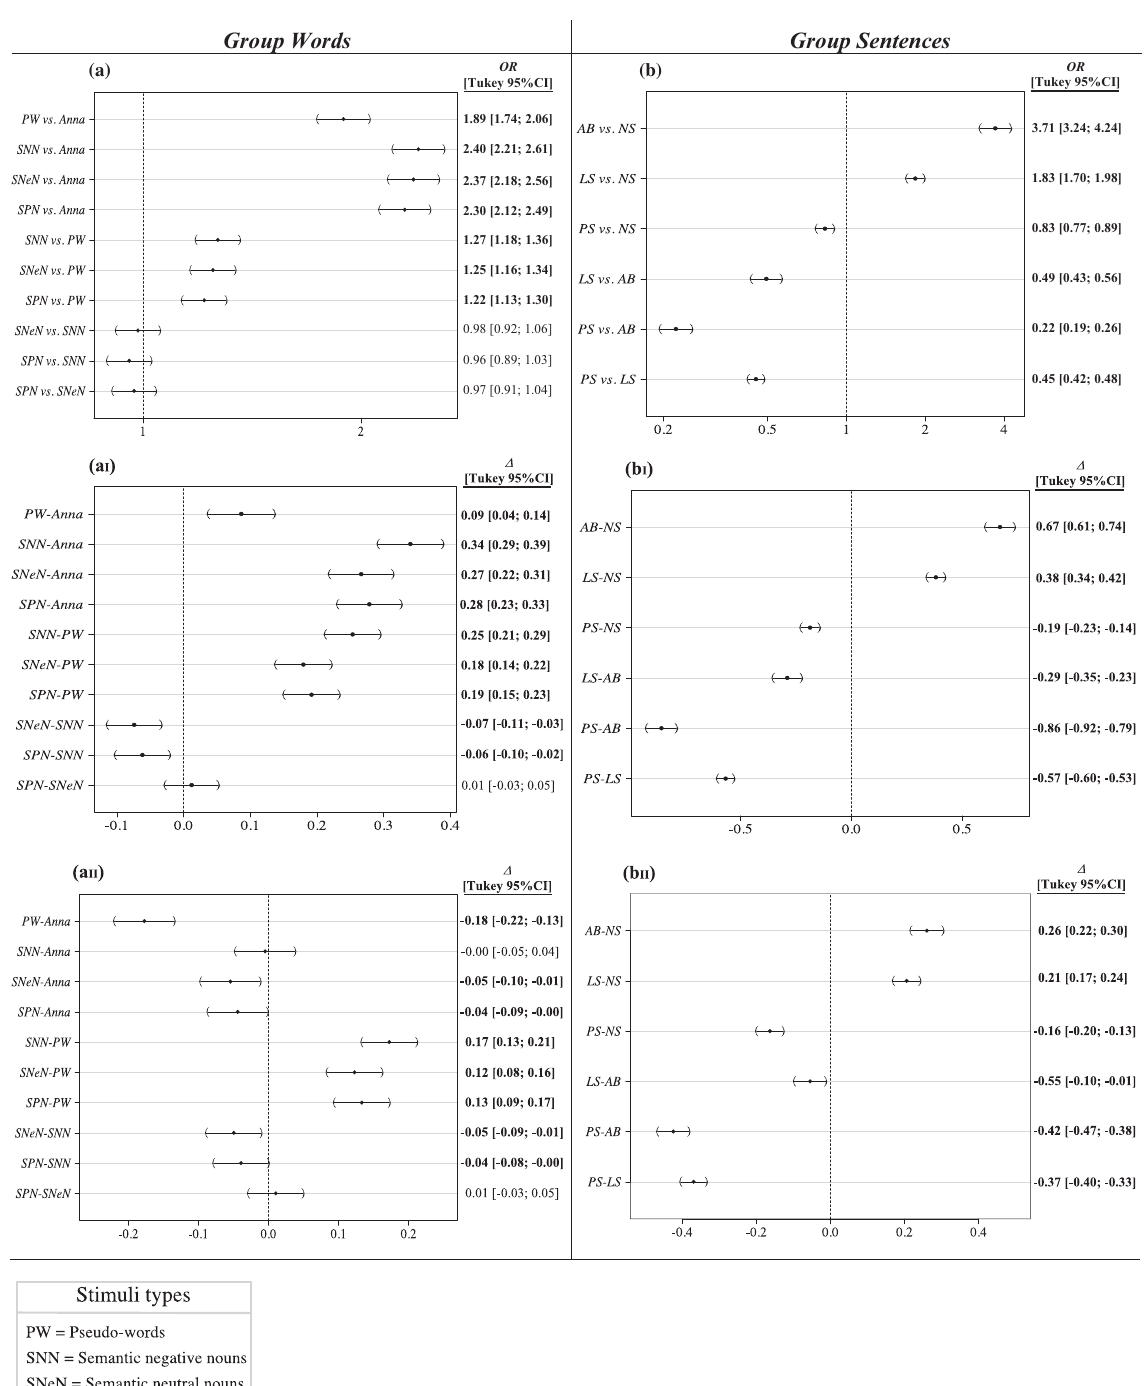
Fig. 2 Comparisons between stimuli types. Emotion recognition odds ratio estimates (OR) for the comparisons between stimuli types are illustrated in panel a and panel b . The linear contrasts ( Δ ) for con fi dence ratings are illustrated in panel a I and b I , while the con fi dence ratings after adjusting for emotion recognition are displayed in panel a II and b II . Odds ratio of stimulus 1 (e.g., AB) vs. stimulus 2 (e.g., NS) less than 1 indicate that the recognition probability of stimulus 2 (e.g., NS) is higher than of stimulus 1 (e.g., AB), whereas values greater than 1 vice-versa. If the odds ratio of 1 is covered in the con fi dence interval, the difference in the recognition probabilities is not signi fi cant. Negative differences of con fi dence ratings of stimulus 1 (e.g., AB) vs. stimulus 2 (e.g., NS) indicate that the con fi dence ratings of stimulus 2 (e.g., NS) is higher than of stimulus 1 (e.g., AB), whereas positive differences vice-versa. If the difference of zero is covered in the 95%CI, the difference in the con fi dence ratings is not signi fi cant. The signi fi cant combinations are highlighted in bold.